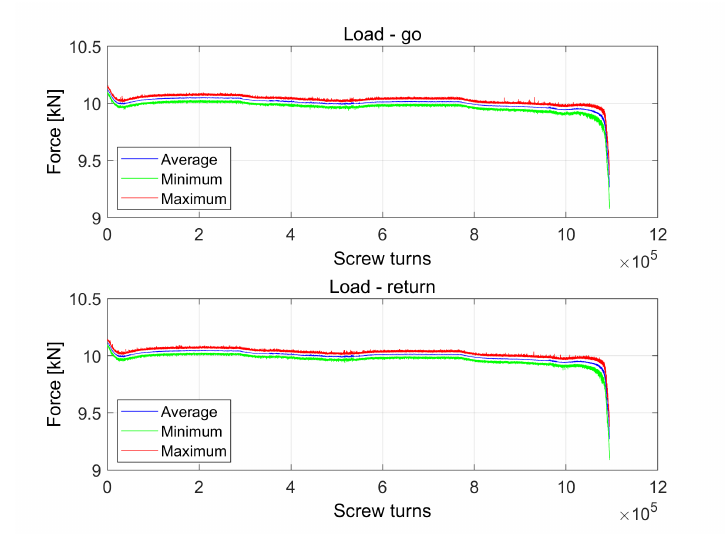
Figure 14. Load applied between the nuts, variation during the endurance test.